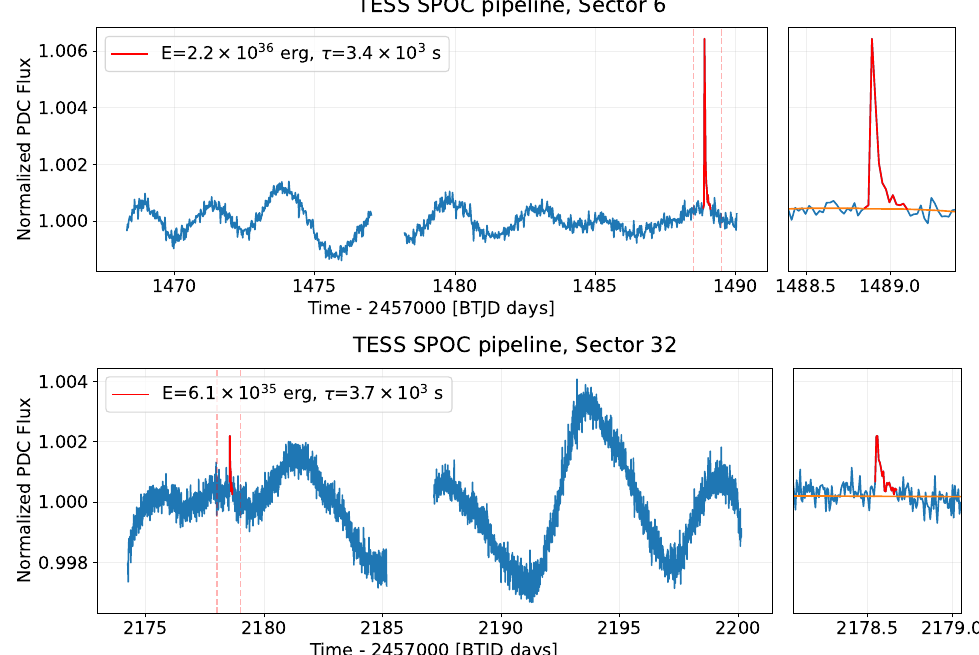
Figure 7. TESS light curves (blue lines) of HD36030 for two sectors when the object was observed. Visually selected flares in both sectors are highlighted in red and also shown in the separate panels on the right. The total energies of the flares as well as their durations are also shown. Orange lines represent the smooth interpolation of a quiescent light curve behaviour during the flare, used for removing background contribution from its